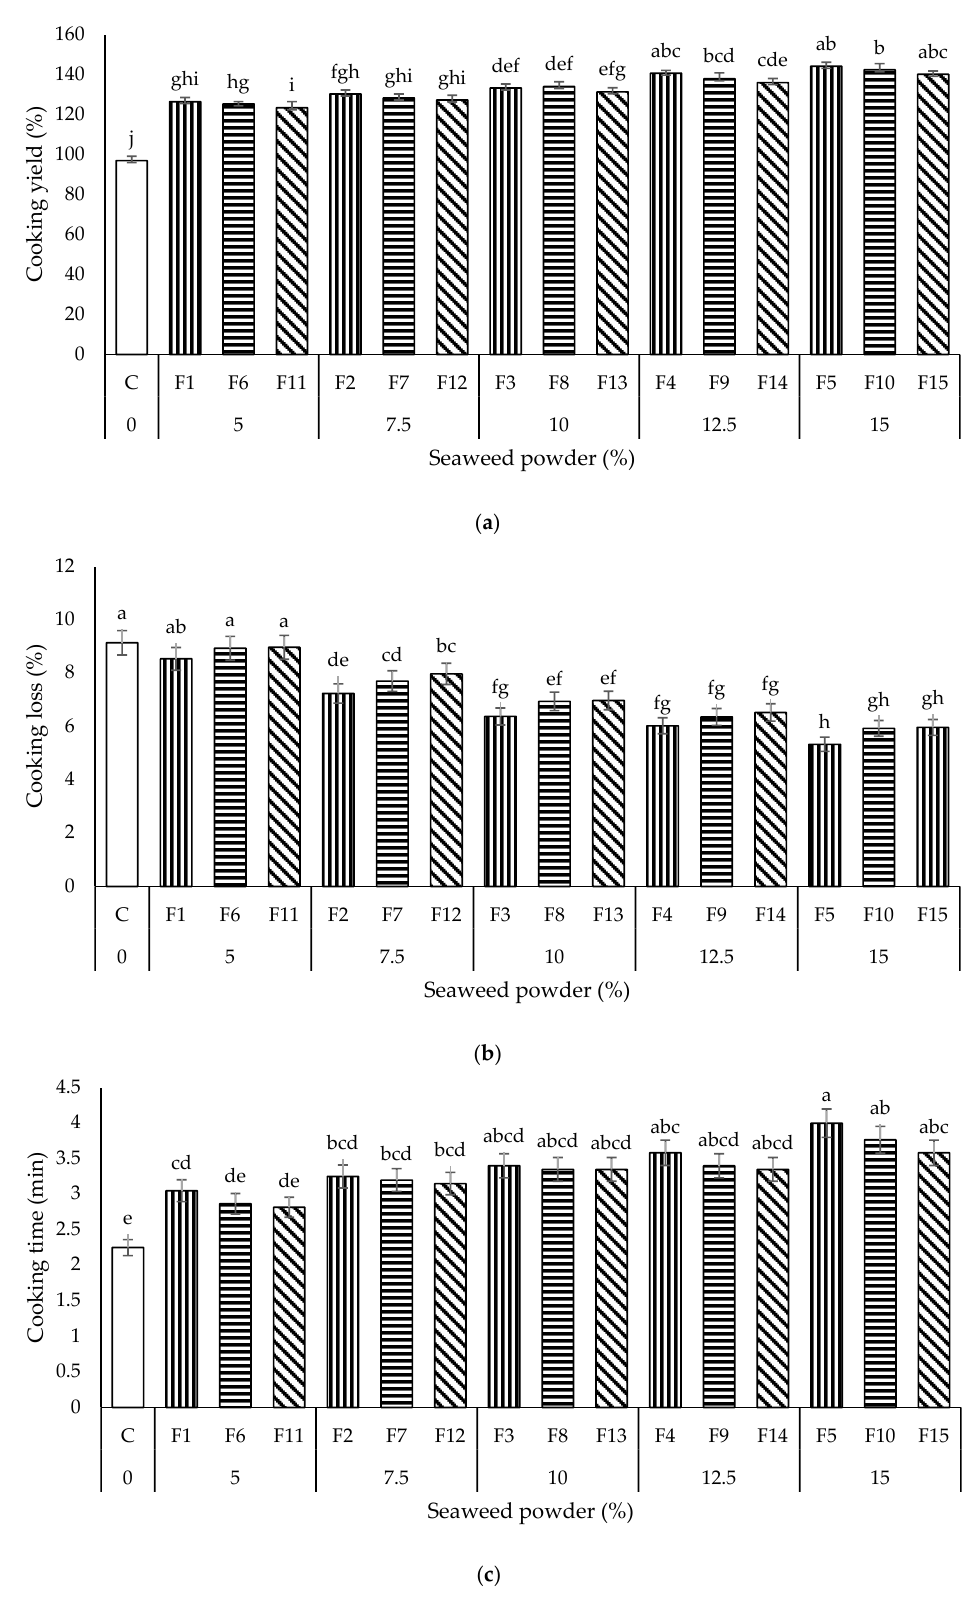
Figure 1. Cooking quality ( a ) cooking yield, ( b ) cooking loss, and ( c ) cooking time of all the noodles samples. Data are presented as mean ± standard deviation ( n = 3). a–e with different superscripts in- dicate the significant difference among the noodle samples (Tukey’s HSD, p < 0.05). Bars with vertical, horizontal, and diagonal patterns = wheat flour:potato starch ratios of 9:1, 8:2, and 7:3, respec- tively.